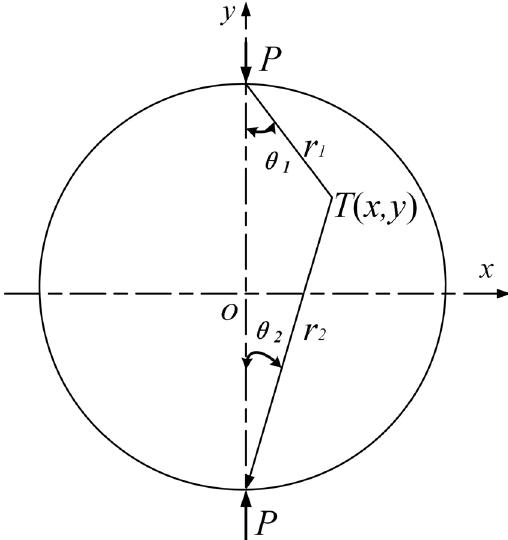
Figure 3. Schematic illustration of the quasi-static splitting